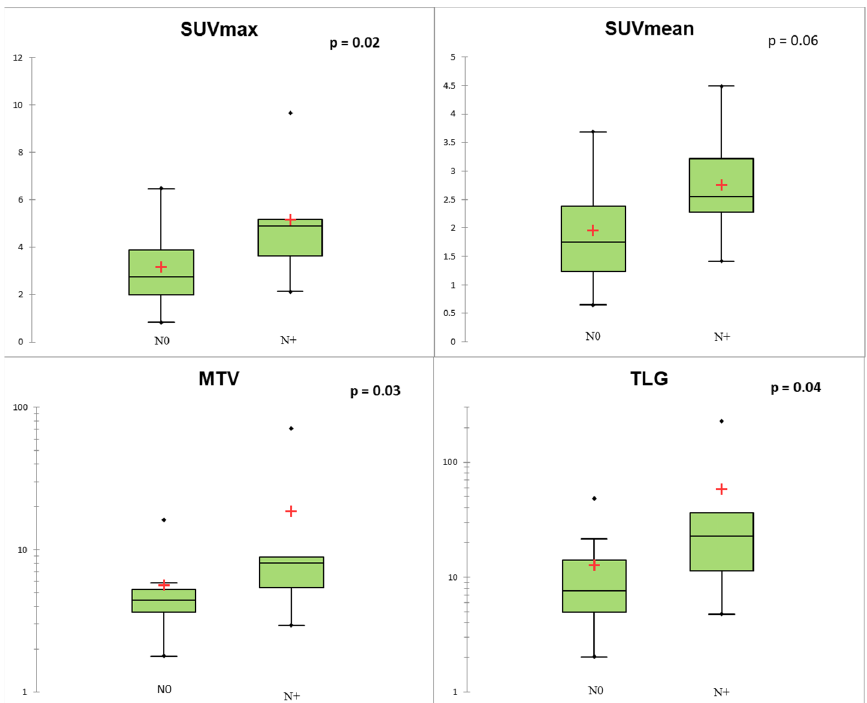
Figure 4. Conventional and volumetric parameters according to N status. The red crosses correspond to the mean value. The central horizontal bars correspond to the median value. The lower and upper limits of the boxes are the first and third quartiles. The error bars are the first decile and the ninth decile; the rhombuses are the minimum and maximum for each parameter.